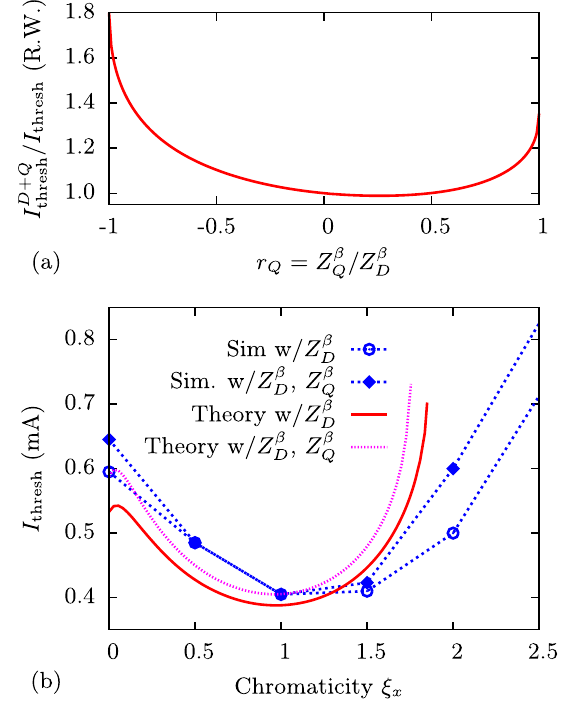
FIG. 5. (a) Change in the resistive wall instability threshold 0 as a function of the quadrupolar to dipolar current at ξ x ¼ impedance ratio r . (b) Comparison of the two-mode theory and Q simulation for the purely dipolar impedance Z Z Z D þ Q